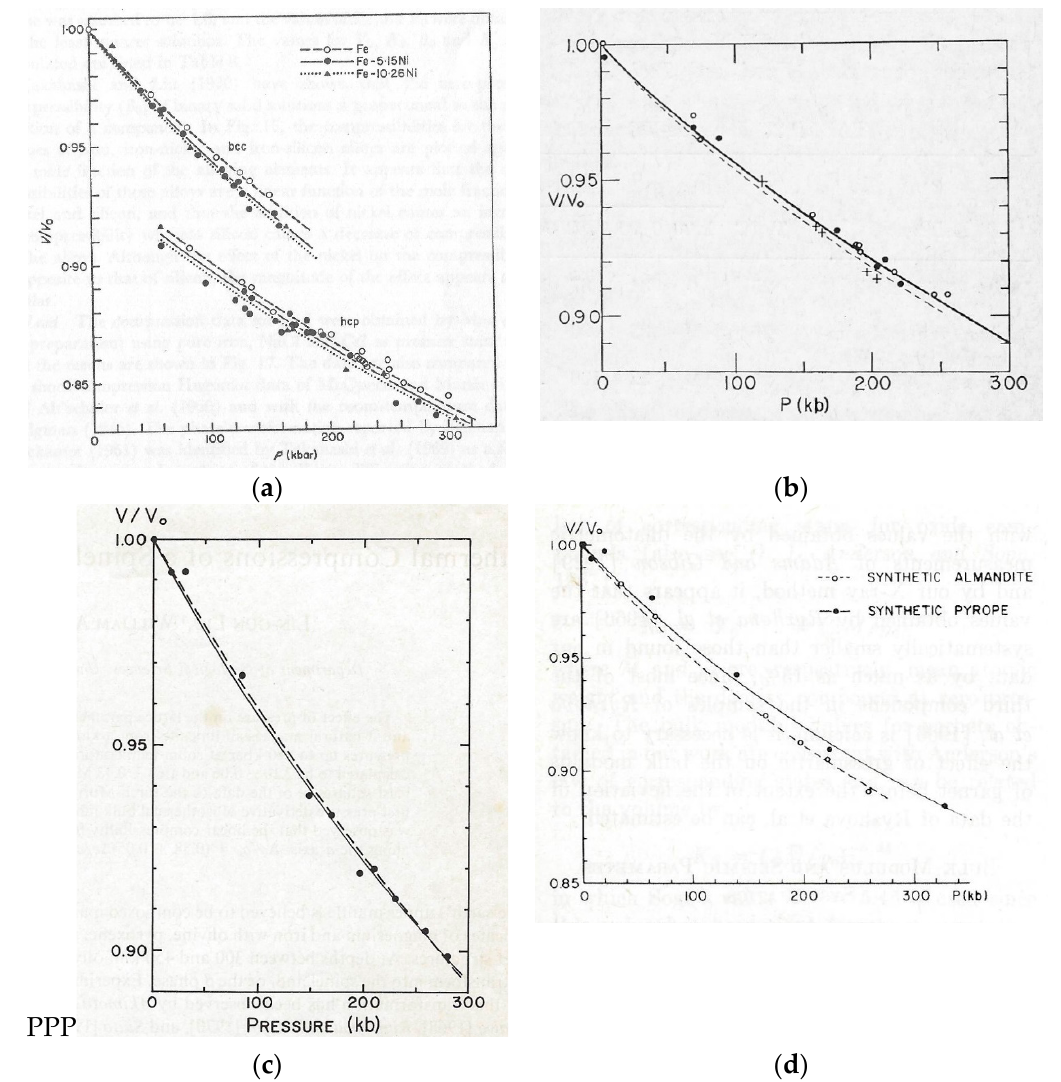
Figure 3. Four examples of early measurements of isothermal compression at 25 °C of phases important for interpreting data concerning the Earth’s interior using lattice parameters based on X-ray diffraction ( a ) Fe, Fe-5.15 Ni , Fe-10.26 Ni [5]; ( b ) Three spinel phases of synthesized Fe 2 SiO 4 (open circles), Fe 1.8 Mg 0.2 SiO 4 (pluses), Fe 1.6 Mg 0.4 SiO 4 (closed circles) [6]; ( c ) Spinel phase of synthesized Co 2 SiO 4 dashed and solid lines by two slightly different least-square fits [7]; ( d ) Two garnet compositions [8].